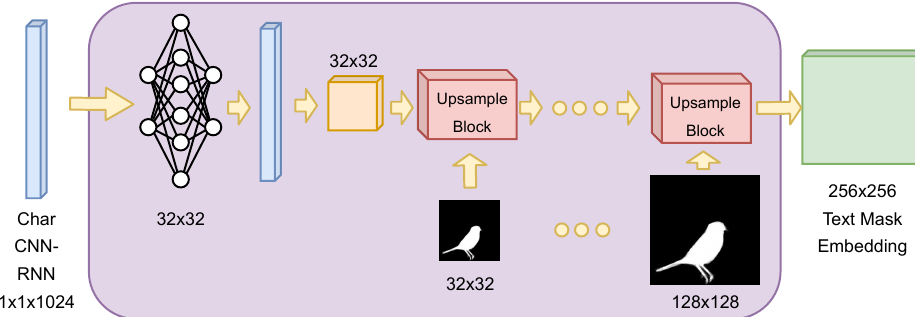
Figure 3. The Text Mask Generator structure exploits the binary masks, corresponding to the sketch area, into the transposed convolutional